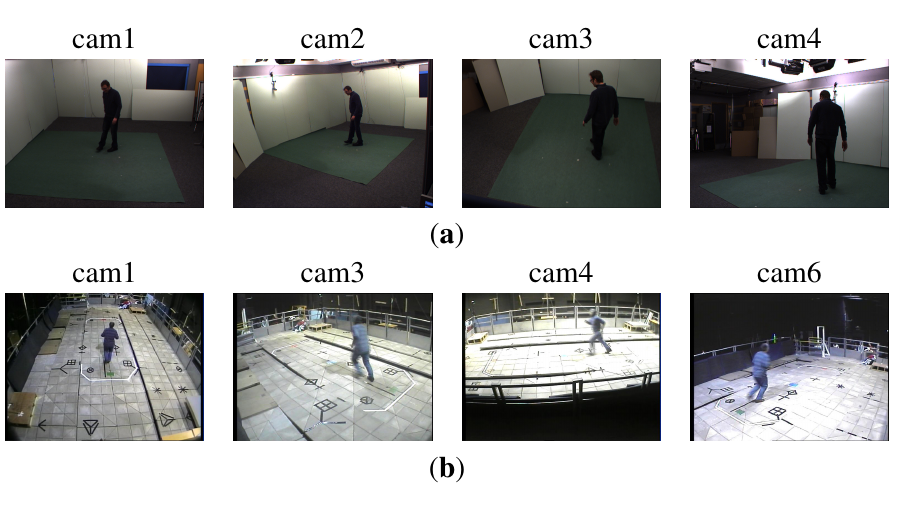
Figure 5. Sample frames from the action datasets. ( a ) IXMAS; ( b )